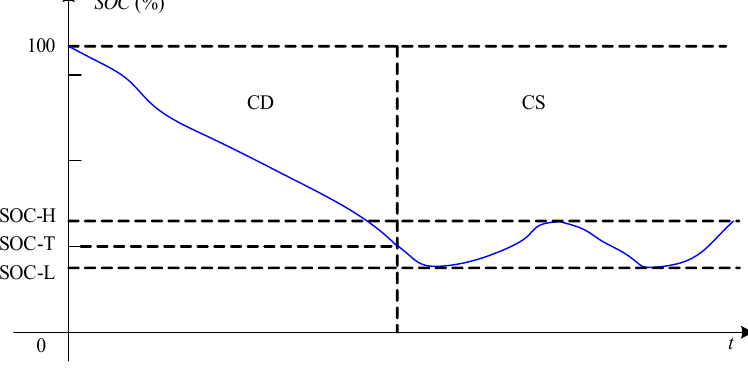
Figure 2. Charge-depleting (CD) and charge-sustaining (CS) periods of the battery. SOC: state of